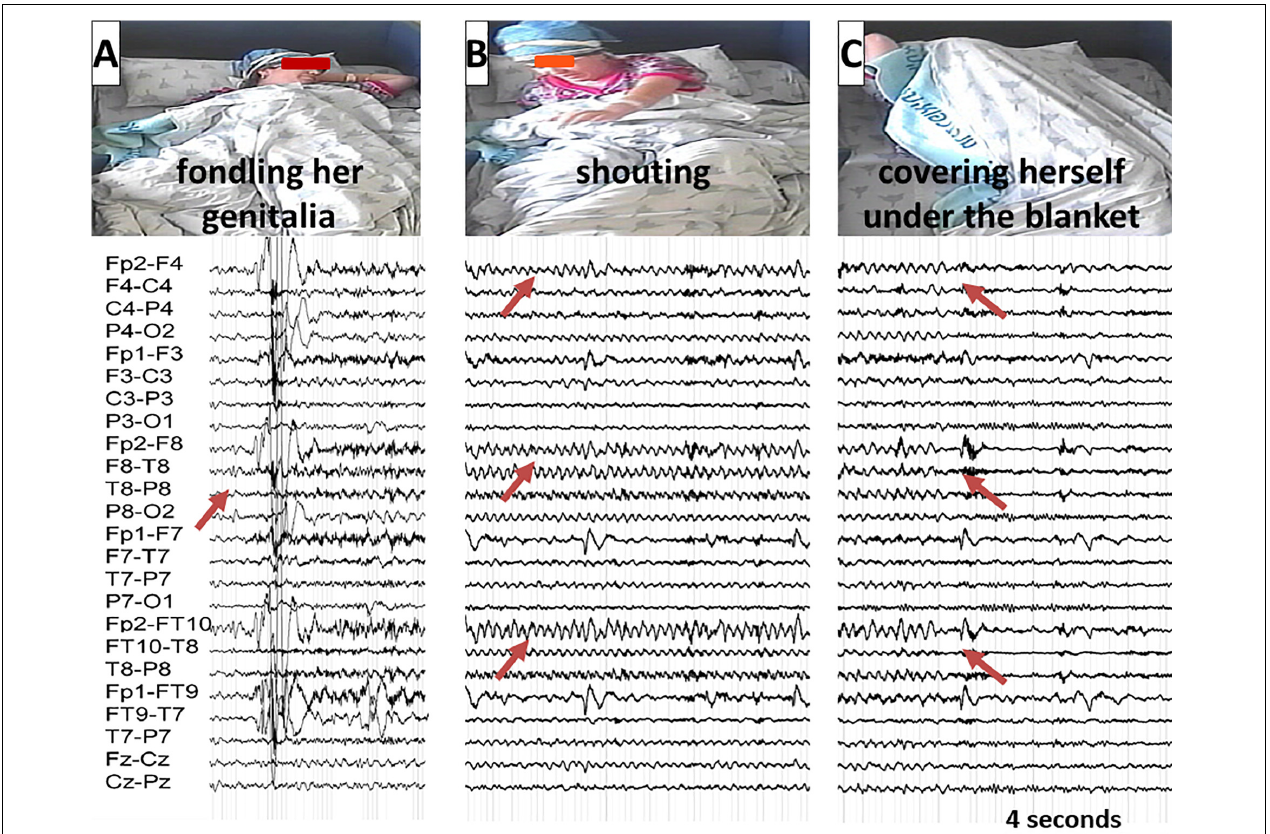
FIGURE 2 | A typical seizure sequence lasting approximately 3 min with the corresponding EEG recording illustrated from left to right: (A) The patient is fondling her groin. The Arrow marks the ictal EEG onset over the right temporal regions; (B) The patient is shouting. The Arrows mark the seizure spread over the right frontotemporal regions; (C) The patient is covering herself under her blanket. The arrows mark the seizure end. (The patient gave her written and informed consent for the use of these images in the